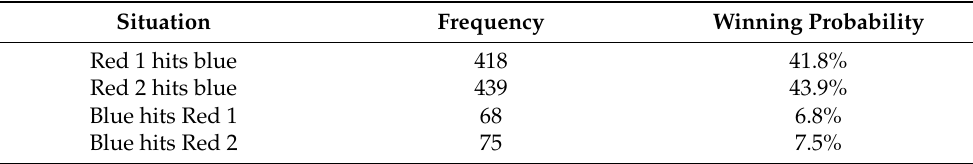
Figure 9. Comparison of the MAPPO and PPO algorithms. Table 4. Statistics of